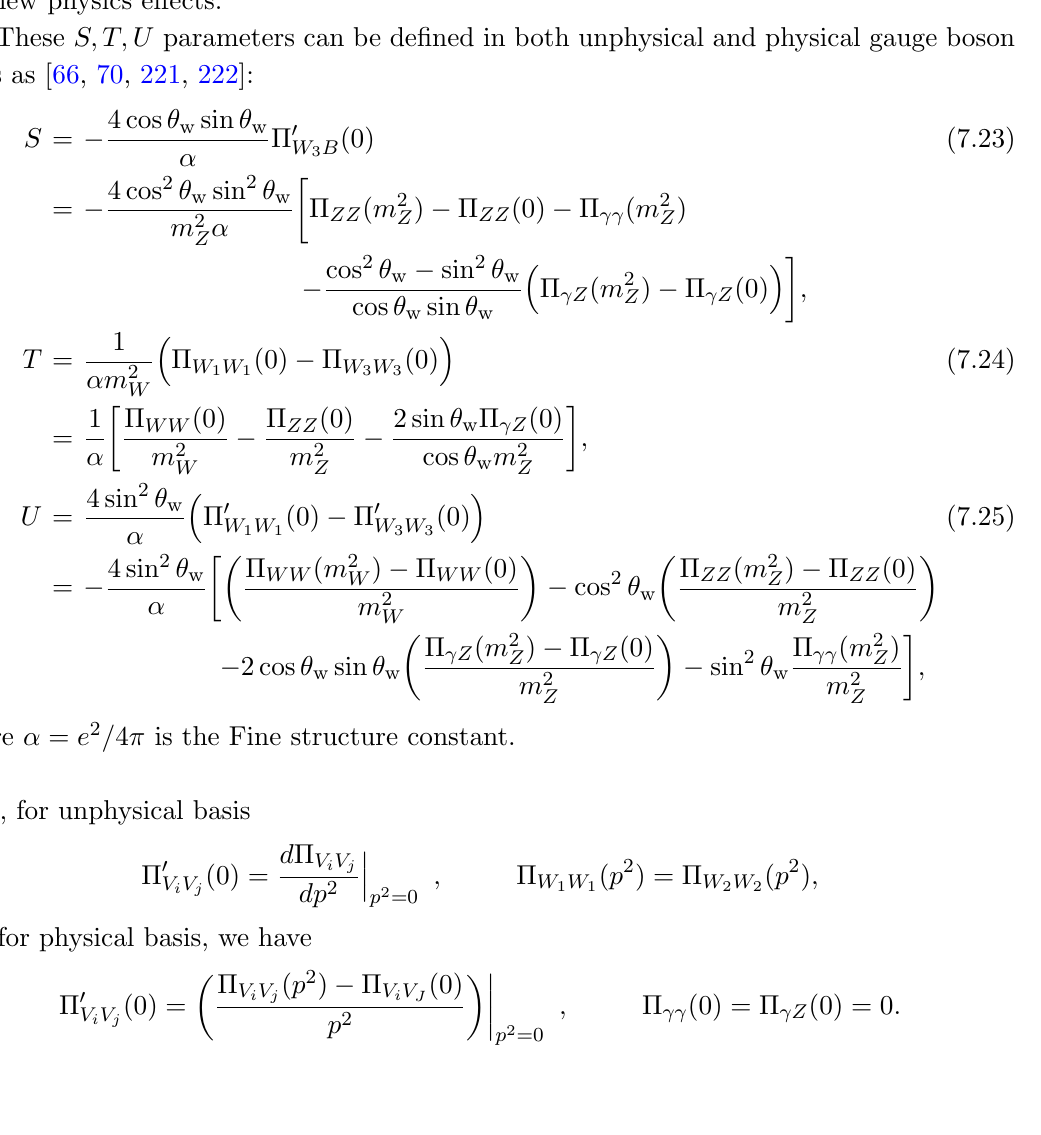
Figure 7. The e(cid:11)ective two-point vector boson correlation function. The [ corrections due to the dimension-6